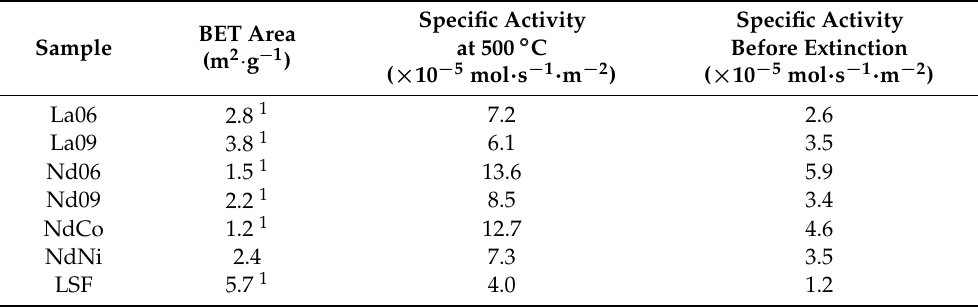
Table 1. Results of catalytic tests: Specific activities at 500 ◦ C (heating experiments) and shortly before extinction (cooling experiments). BET areas used to calculate activities are also